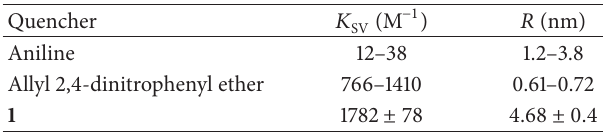
is the Stern-Volmer constant and 𝑅 is action quenching model ( 𝐾 SV the action radius) [10,